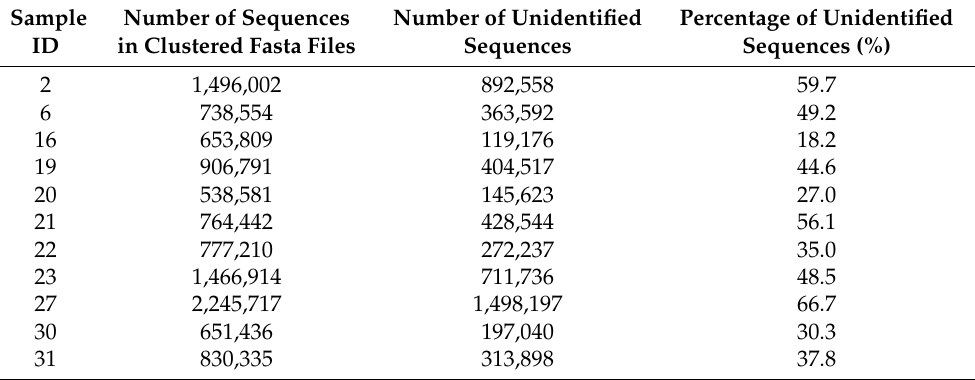
Table 1. The numbers of sequences in clustered fasta files and the numbers of sequences that were not assigned to any taxon.